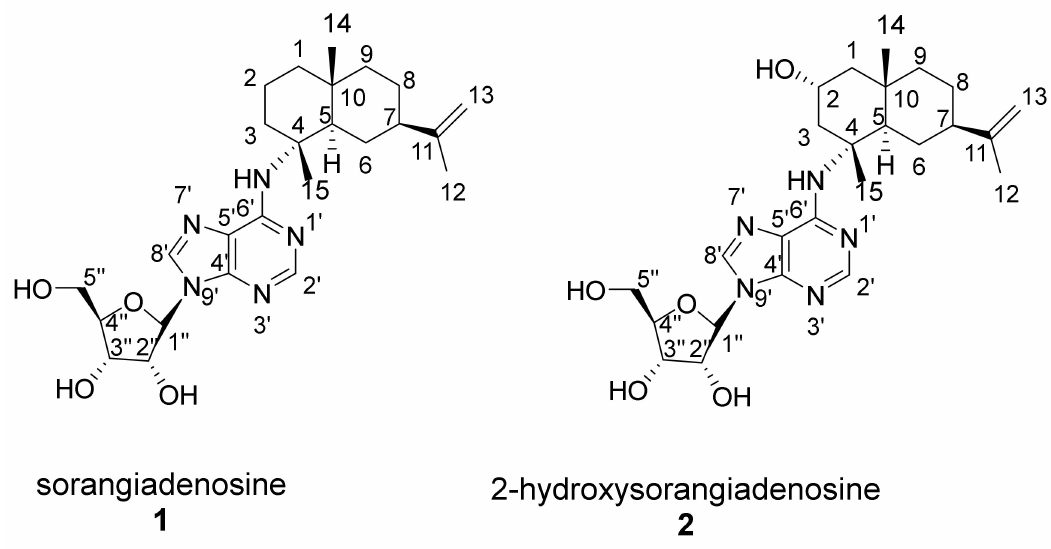
Figure 3. Chemical structure and numbering of sorangiadenosine ( 1 ) and 2-hydroxysorangiadenosine ( 2